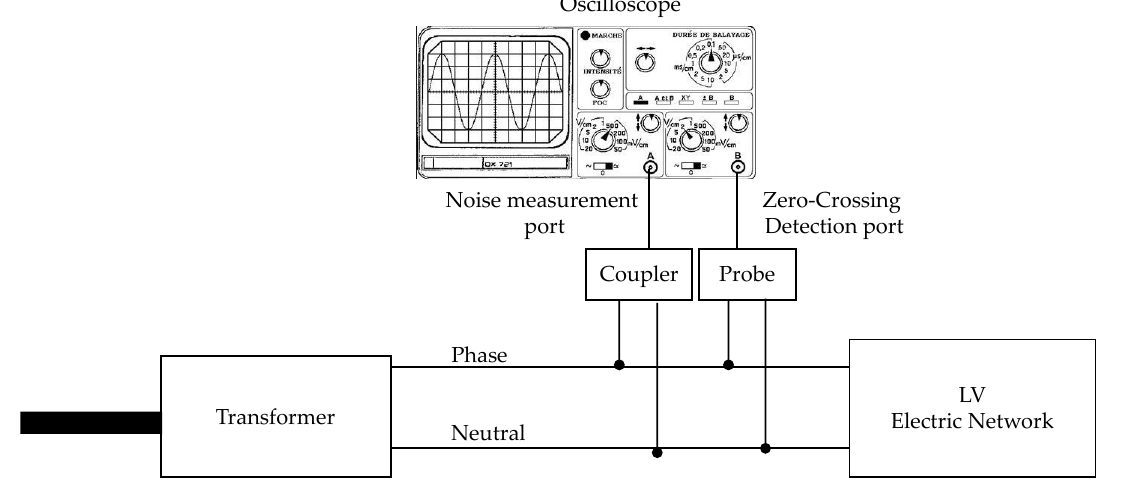
Figure 6. Temporal measurement setup in the transformer substation.